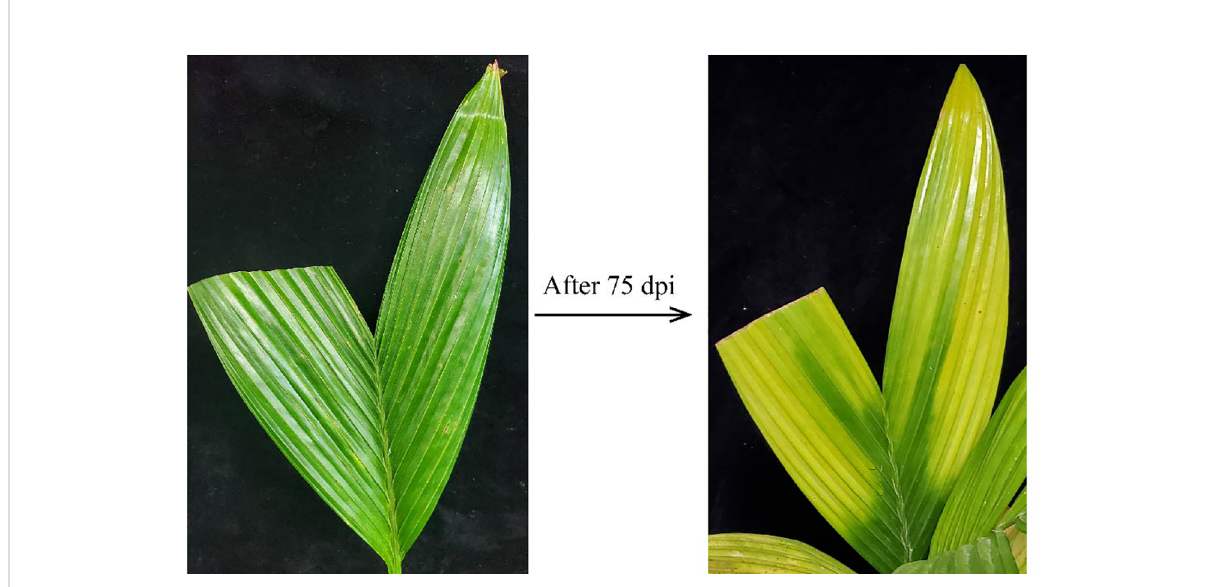
FIGURE 4 APV1 YLD symptoms emerged after 75 days post-inoculation